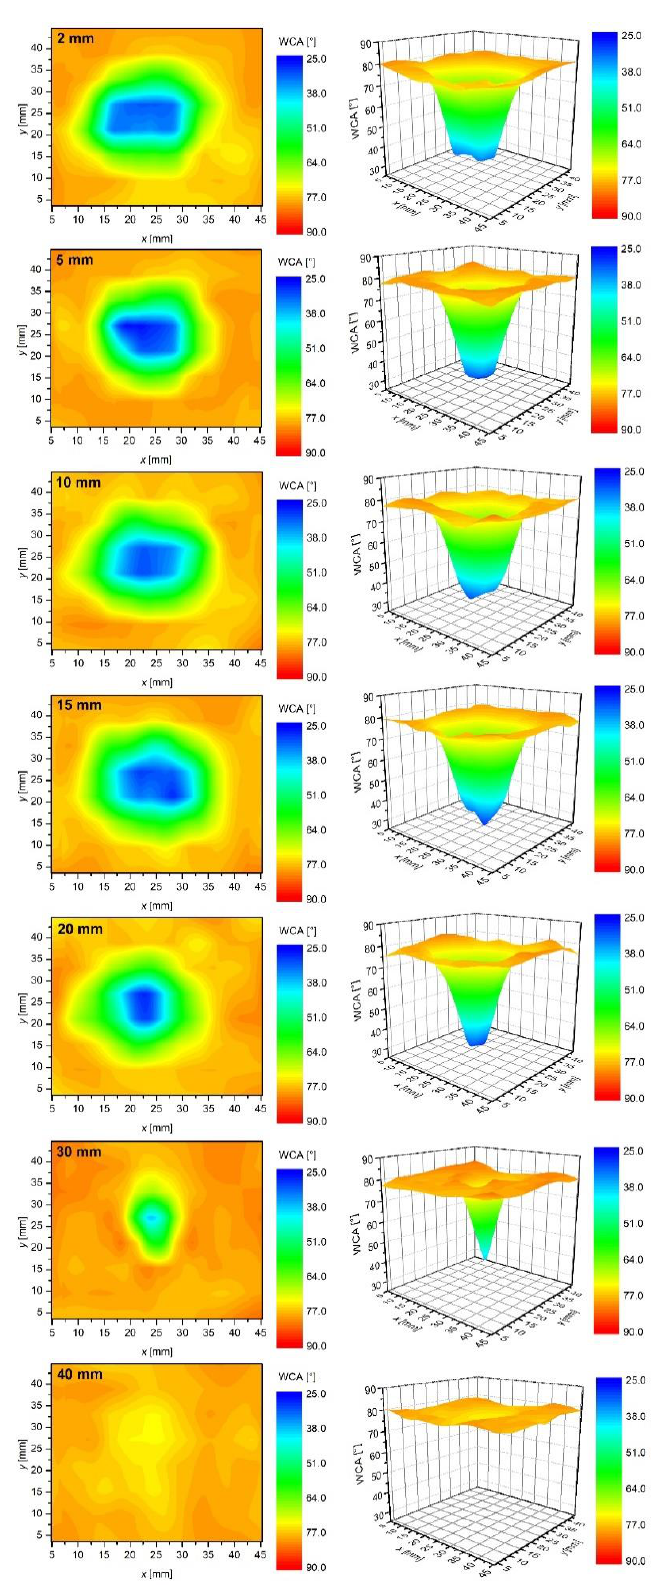
Figure 10. The water contact angles on samples treated for 30 s at different distances between the APPJ nozzle and samples. The visual length of plasma jet is below 30 mm from the nozzle.